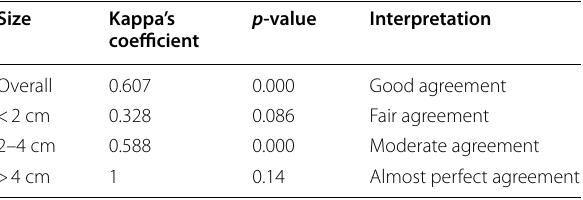
Table 3 Cohen Kappa’s coefficient for inter-rater agreement between USG-guided FNAC findings and histopathological findings according to different sizes of nodules